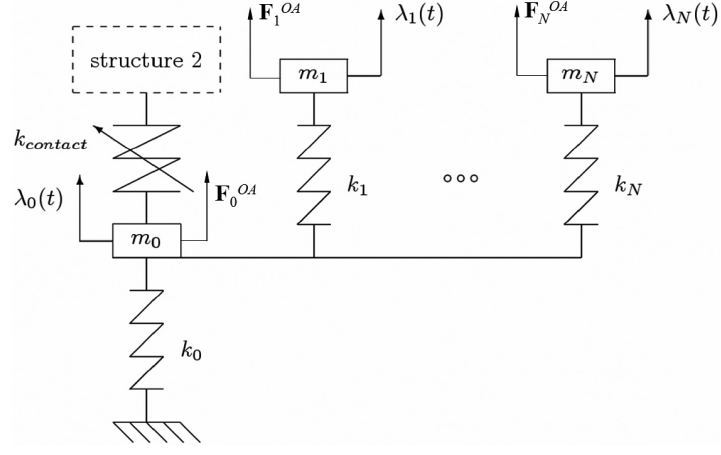
Fig. 1. Model of a structure impacted by another